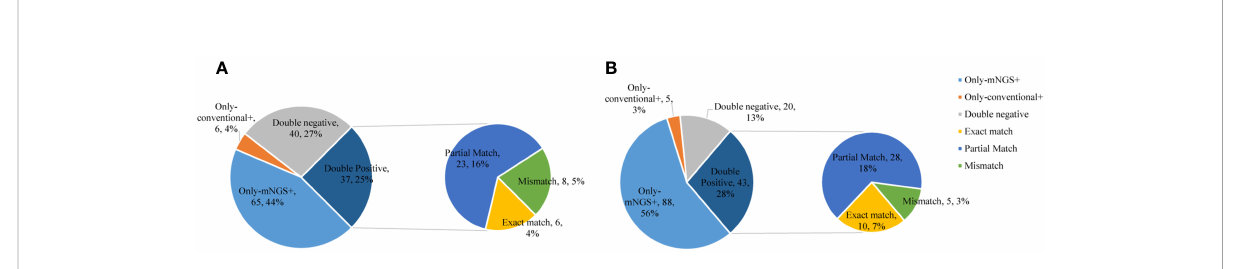
FIGURE 4 Comparison of the consistency between metagenomic next-generation sequencing (mNGS) and conventional tests. (A) Commercial group. (B) In-house